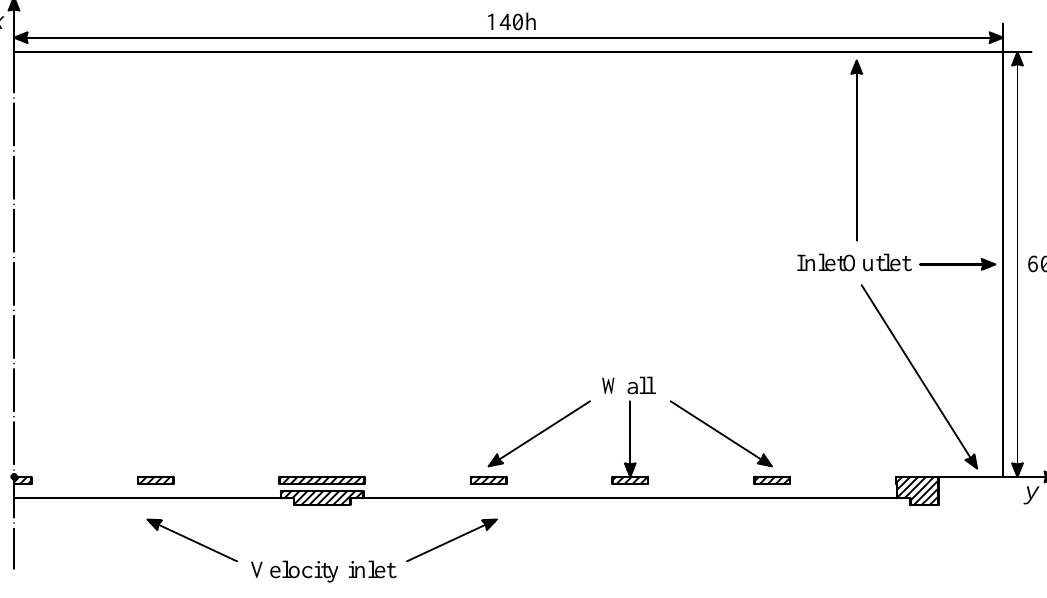
Figure 3. Domain and boundary conditions used in the numerical simulations. Only half of the computational domain is represented in the